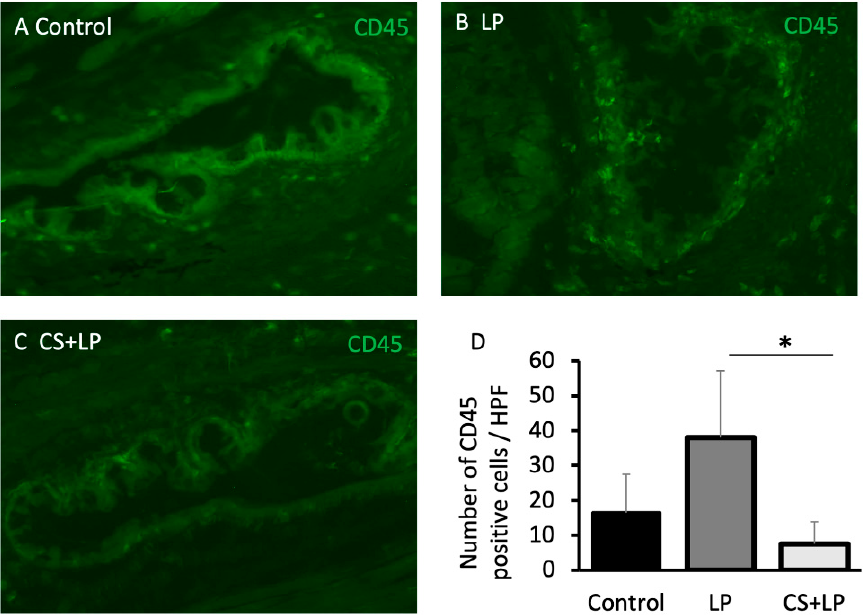
Figure 5. Conjunctival CD45 immunohistochemistry staining and CD45 positive conjunctival cell count comparisons. ( A – C ) Note the abundance of CD45 positive inflammatory cells in the conjunctival epithelium in Group 2 (LP group) compared with Group 3 (CS + LP group). ( D ) Note the significantly increased CD45 positive inflammatory cell counts in the LP group compared with the CS + LP group ( p = 0.02). * represents p < 0.05.